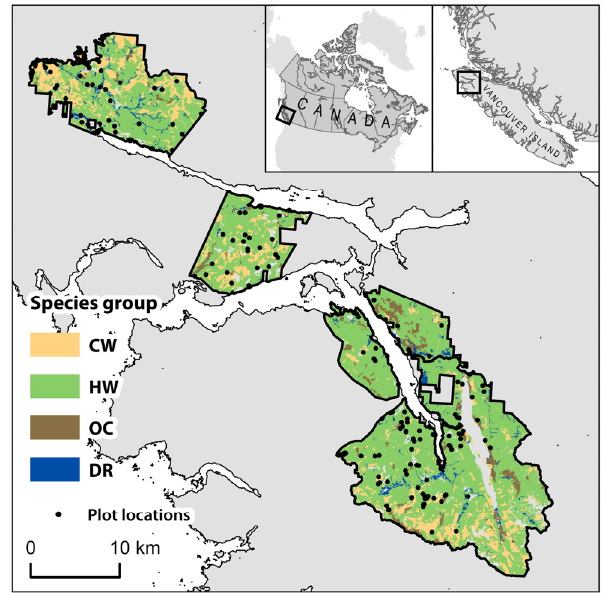
Figure 1. Study area location with species groups distribution and inventory plot locations. Species group abbreviations explained in Table 1.